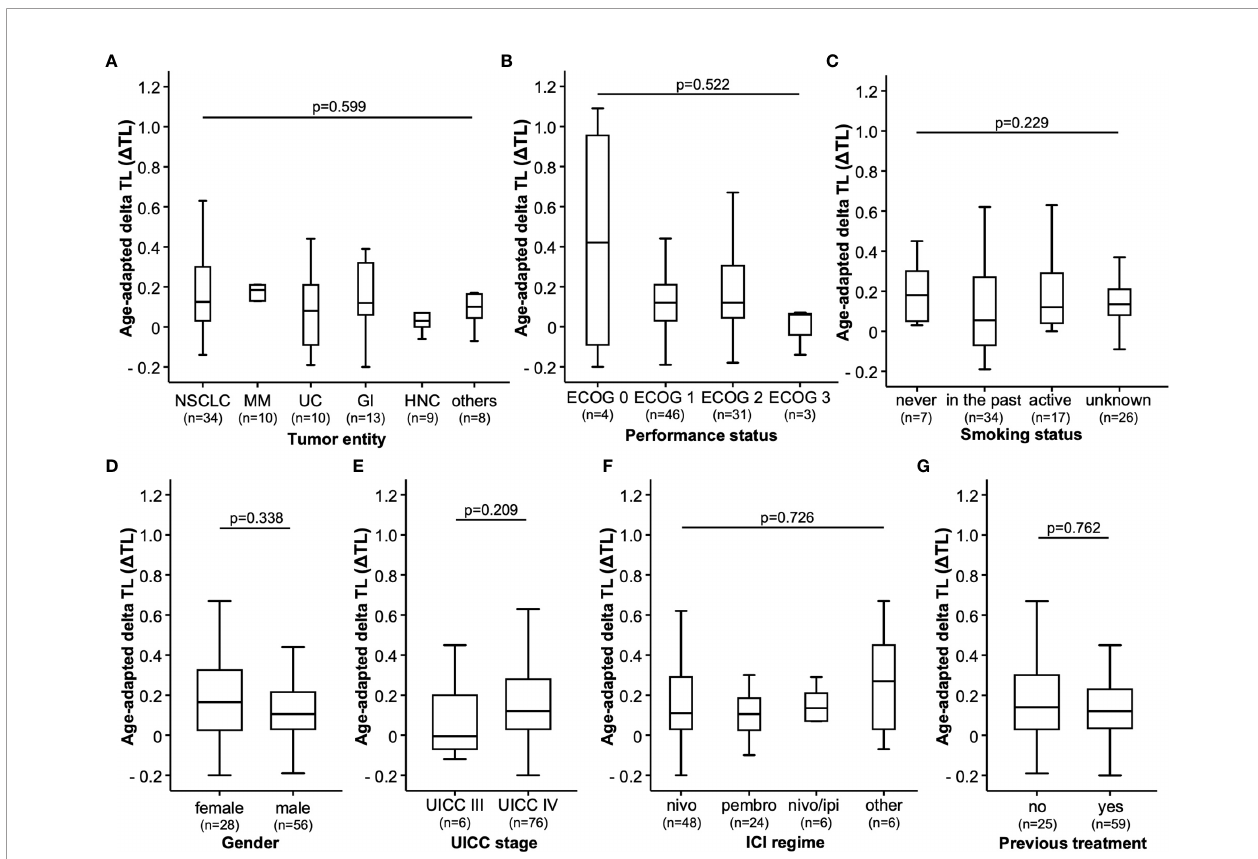
FIGURE 1 | Study population. The age-adapted delta telomere length ( D TL) is shown in patients with different (A) tumor entities [non-small cell lung cancer (NSCLC), malignant melanoma (MM), urothelial cancer (UC), gastrointestinal cancer (GI) head and neck cancer (HNC) and other tumor types (other)], (B) ECOG performance status, (C) smoking status, (D) gender of the patient, (E) advanced tumor stages classi fi ed by the UICC, (F) type of immunotherapeutics (nivolumab (nivo), pembrolizumab (pembro), a combination of nivolumab and ipilimumab (nivo/ipi) or other immunotherapeutics (other) and (G) if patients received pre-treatments (yes) or not